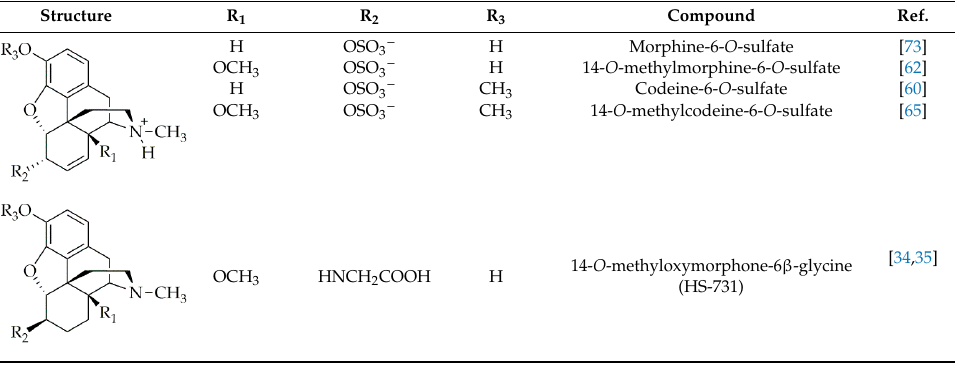
Table 1. Examples of MOR agonists from the class of morphinans with limited CNS penetration and peripheral analgesic effect.